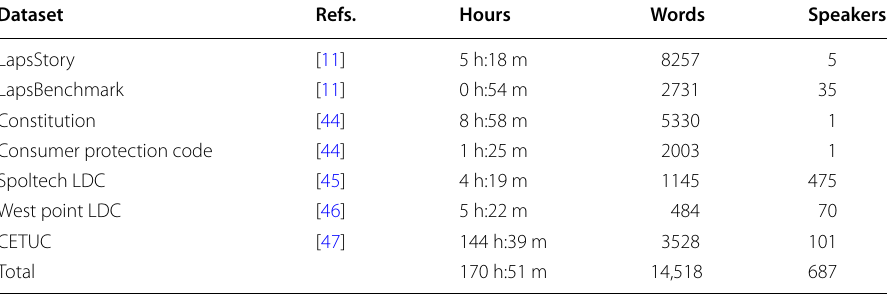
Table 2 Speech corpora used to train acoustic models Dataset